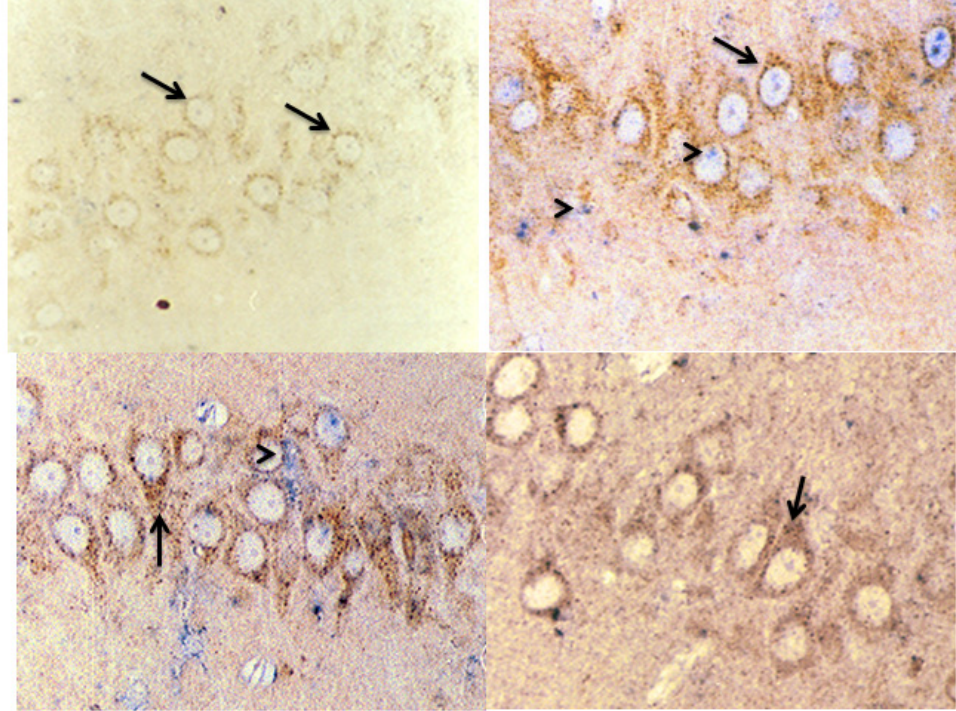
Figure 9. Effect of TBI on the immunoreactivity of cathepsin B and CC in the CA3 region of the hippocampus. Representative micrographs showing the change in the immunoreactivity of cathepsin B (brown) and CC (purple) in rats killed either before TBI ( a ) or at 24 ( b ), 48 ( c ) or 72 ( d ) h after TBI. Cathepsin B was detected in control rats, and the expression level increased 24 h after TBI and decreased after 72 h, whereas CC was detected 24 h after TBI. Magnification: 100×. Arrows indicate cathepsin B staining, and arrowheads indicate cystatin C